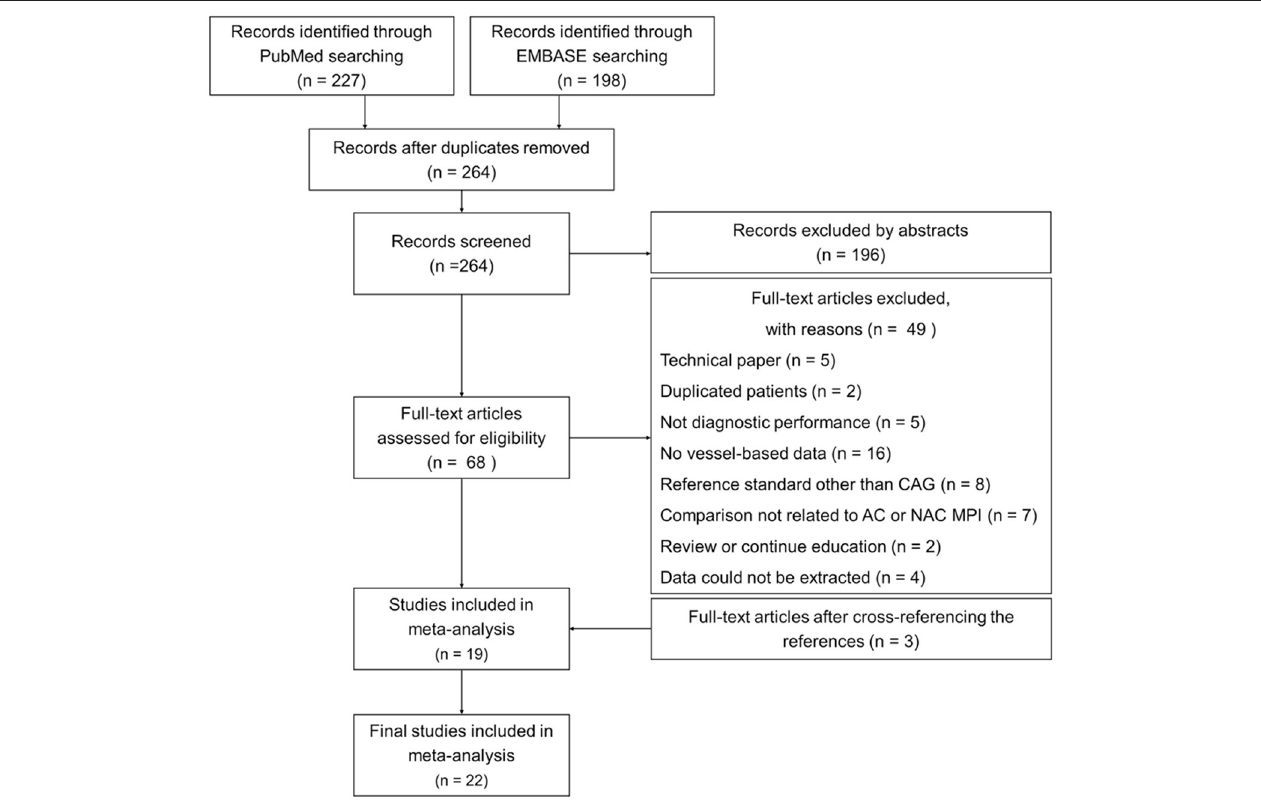
FIGURE 1 | Flowchart of study selection. A total of 22 studies (2,608 patients) were included in the final analysis. AC, attenuation correction; CAG, coronary angiography; MPI, myocardial perfusion imaging; NAC, non-AC.